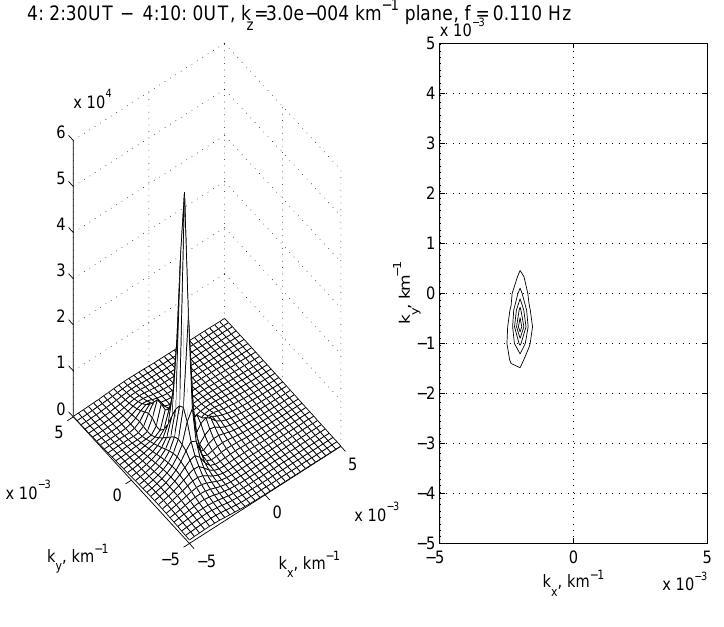
Table 2. Summary of results for the interval 04:02:30 UT–04:10:00 UT